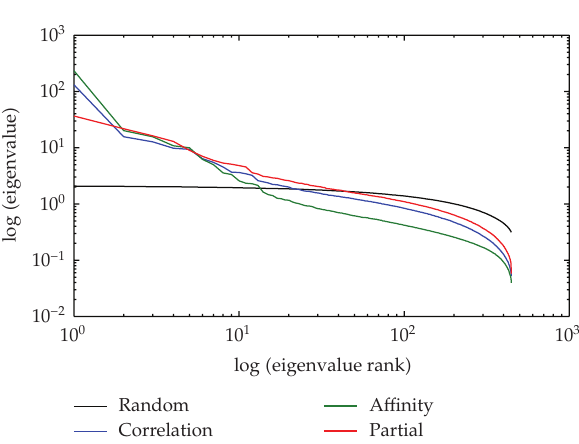
Figure 3: Zipf plot of the S&P dataset. Here we plot the log of the value of the eigenvalue as function of the log of its rank. A power law-like behavior is observed for the raw (cid:3) blue (cid:4) , a ffi nity (cid:3) green (cid:4) , and partial (cid:3) red (cid:4) correlation, in comparison to the random matrix (cid:3) black (cid:4)